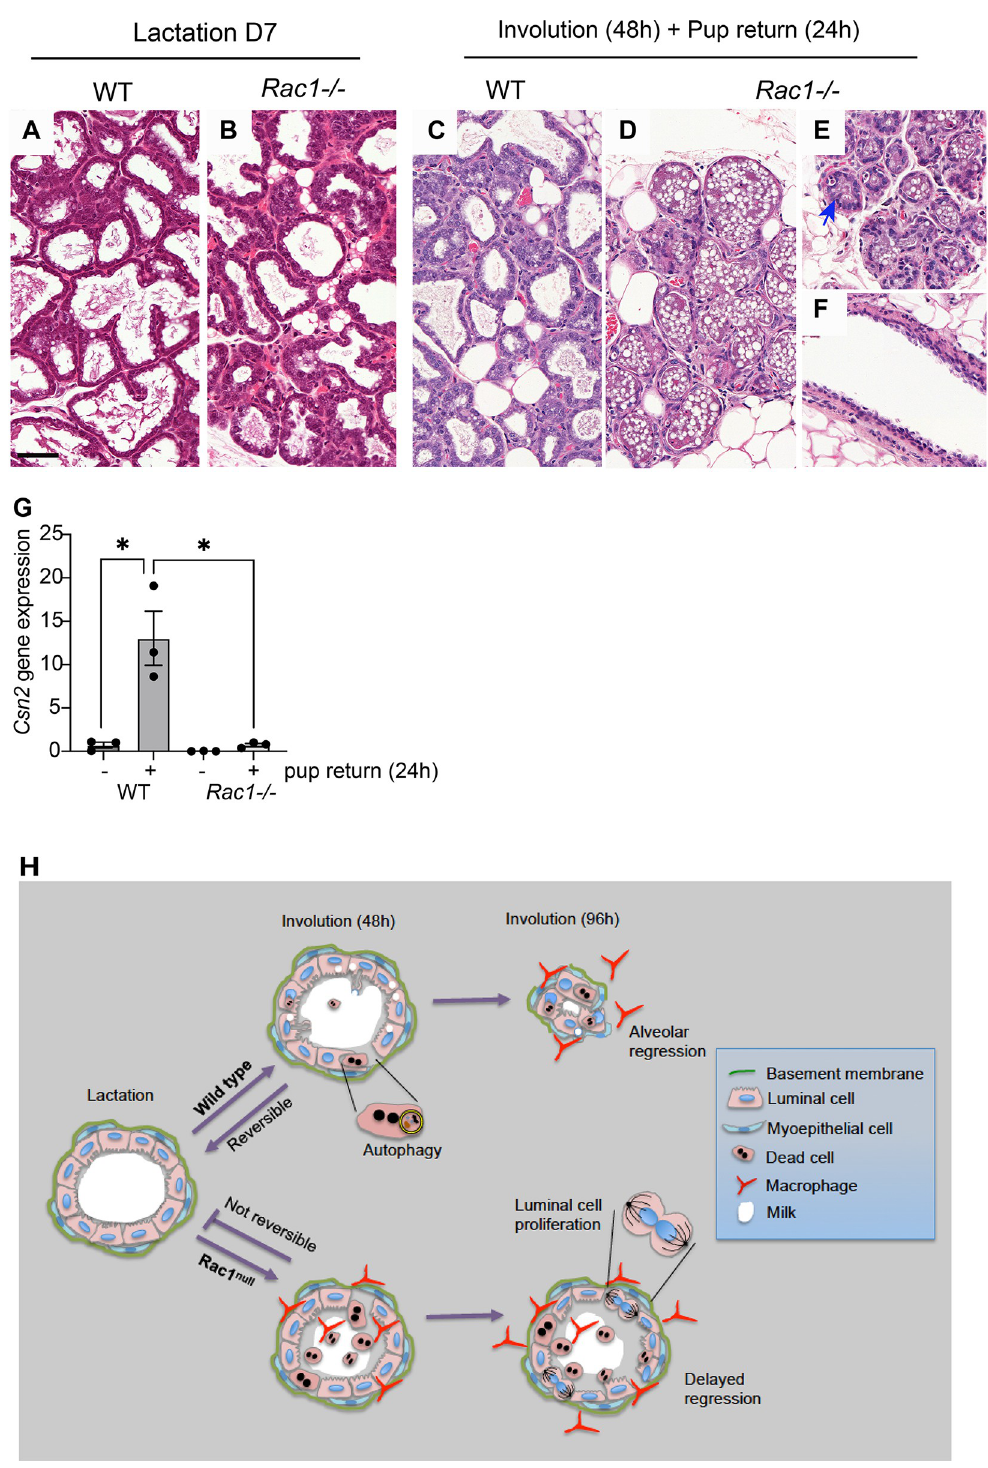
Fig 8. Mammary gland reversibility fails in Rac1−/− involuting glands. ( A - F ) HE stain of WT and Rac1−/− glands at lactation day 7 ( A , B ) and involuted for 48 h and then resuckled for 24 h ( C - F ).WT glands ( C ) resume a lactation morphology while Rac1−/− ( D - F )show an involution phenotype. ( E , F ) show suckled areas in Rac1−/− glands. Bar: 100 μ m. ( G ) Quantitative RT-PCR shows increased casein 2 gene expression in resuckled WT glands, but this is reduced by 18-fold in Rac1−/− glands. Error bars: +/ − SEM of n = 3 mice. ( H ) Summary diagram of Rac1 regulation of mammary